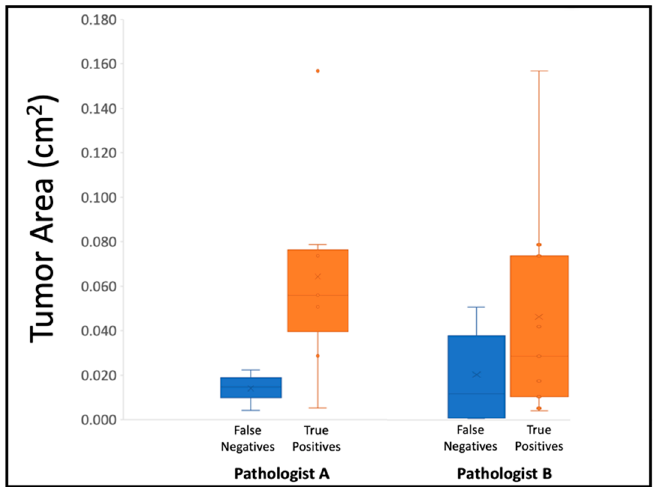
Figure 4. Tumor area on histology slides for false negative and true positive diagnoses on SIM. False negative calls based on SIM images were correlated with low tumor area in the final H&E sections, whereas true positive calls were correlated with higher tumor area.